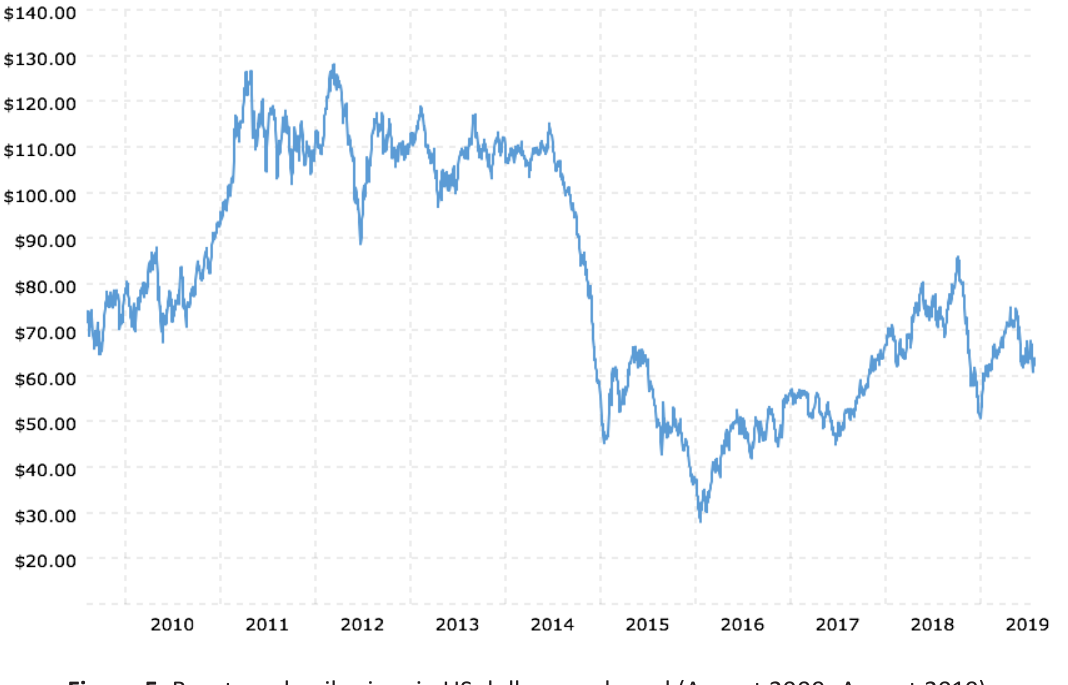
Figure 5. Brent crude oil prices in US dollars per barrel (August 2009–August 2019)